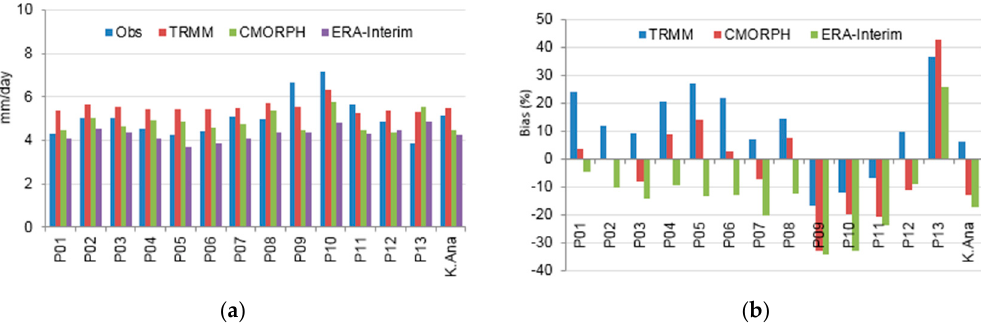
Figure 3. Validation of SBRP against GMP at daily scale: ( a ) Mean daily rainfall and ( b ) bias (%) at different stations.